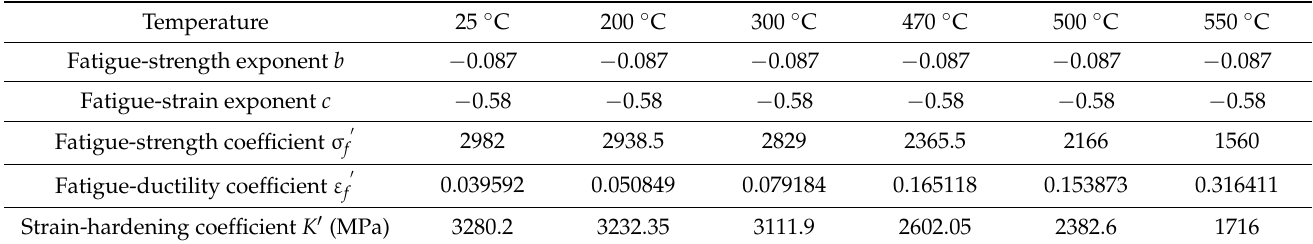
Table 6. Mechanical properties describing fatigue model SLM 1.2709 maraging steel.